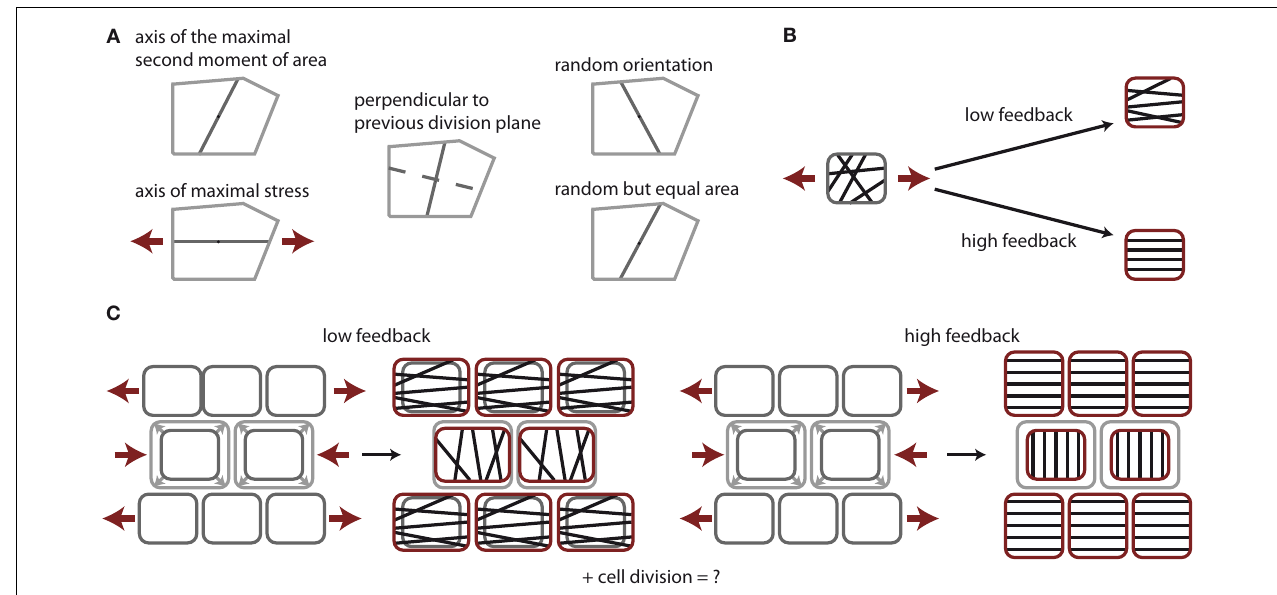
whereas only to some extent at low feedback. (C) Impact on stress feedback on growth homogeneity. At low feedback the stress arising due to the overgrowth of the center cells induces a stress field that slightly suppresses vertical growth in the center cells, while surrounding cells grow horizontally to maintain tissue contiguity, thus driving homogeneous growth. At high feedback cells cannot grow along the main direction of stress at all.The growth of the cells in the center is completely halted but surrounding cells continue to grow vertically, establishing steep gradients in growth between